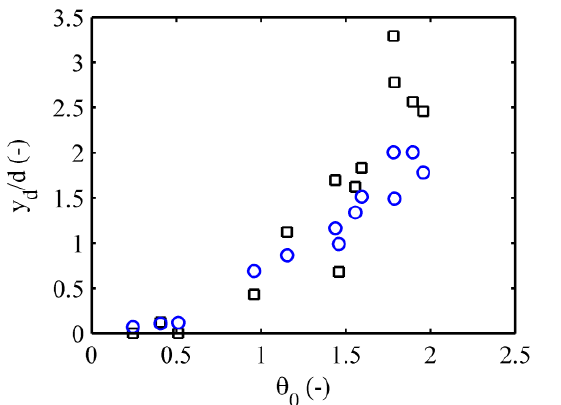
Fig. 11. Thickness of dense part of transport layer versus dimensionless bed shear stress for FA60 flow. Legend: black square – experiment, blue circle – model prediction.